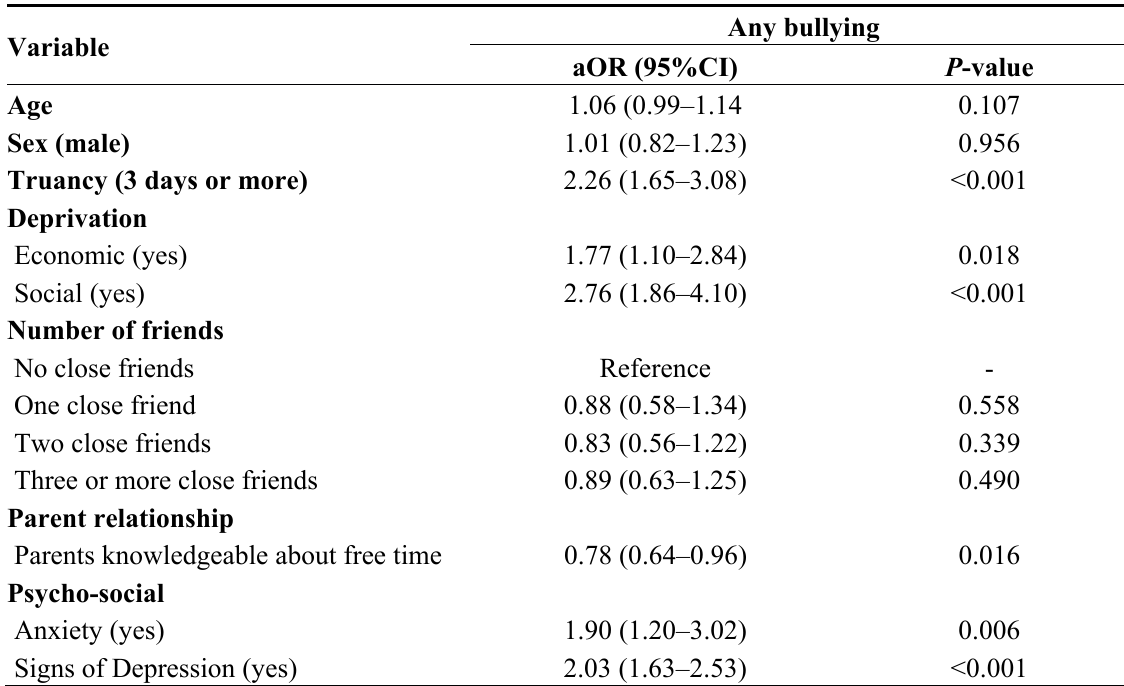
Table 3. Multivariate analysis of bullied vs . non-bullied adolescents in Dar es Salaam, Tanzania (2006).